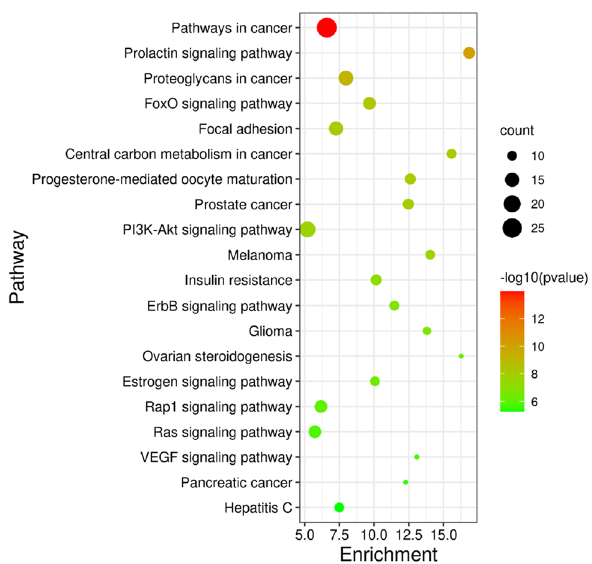
Fig. 4 Top 20 most significantly enriched signaling pathways regulated by the active ingredients of S. nigrum in breast cancer (revealed by KEGG pathway analysis). Dot color and size represent p-value range and gene number mapped to the indicated path- ways,